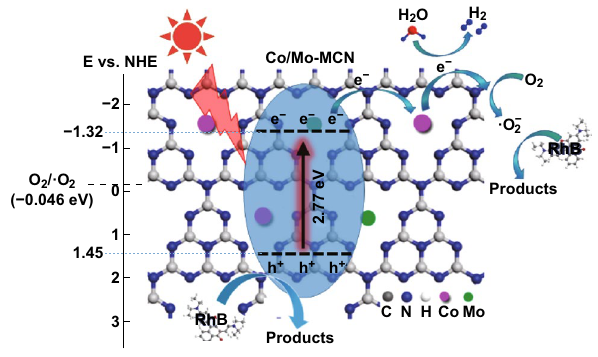
Fig. 12 Photocatalytic mechanism scheme of Co/Mo-MCN under visible light